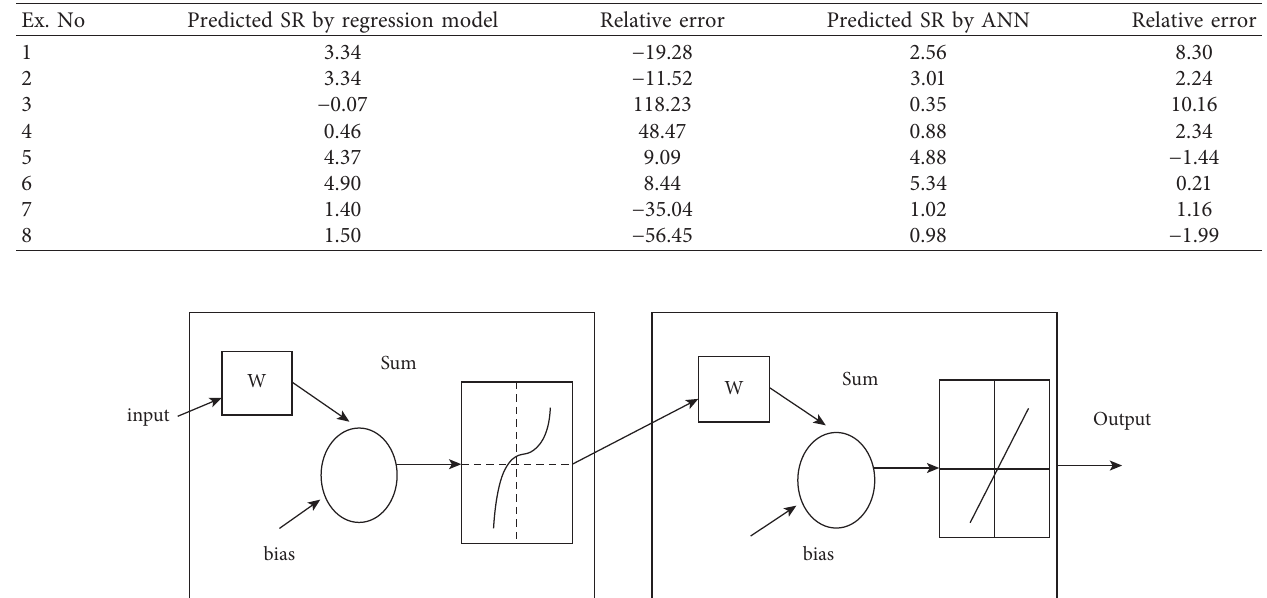
Table 6: The predicted outputs of SR and relative error by ANN and regression model.